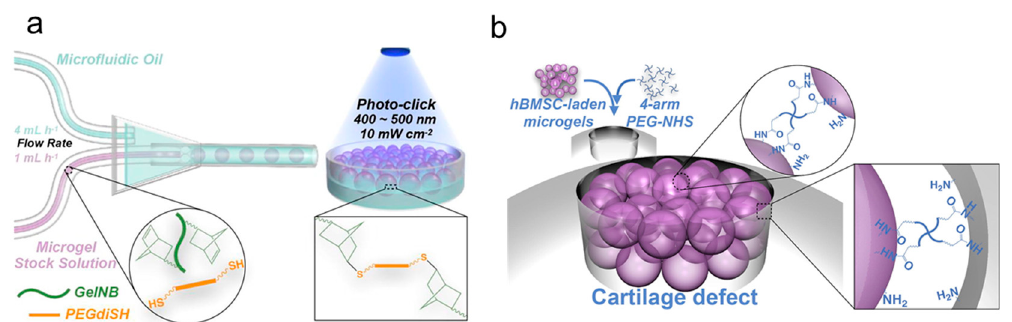
Figure 3. Scheme illustrating microgel formation using a pipette tip-based microfluidic device ( a ). The 4-arm poly(ethylene glycol)-N-hydroxysuccinimide (PEG-NHS) was used as covalent crosslinker for bottom-up assembly of human bone marrow derived mesenchymal stem cells (hBMSC)-laden microgels for tissue formation ( b ) [111]. (Reproduced with permission from Elsevier.)